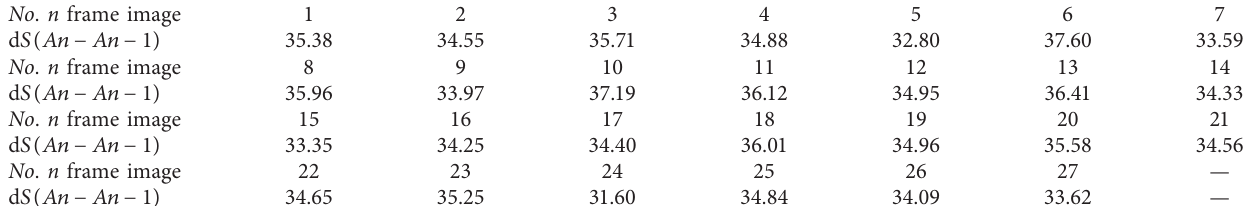
Table 1: Calculation results of the displacement between 28 image sequences (unit: cm).